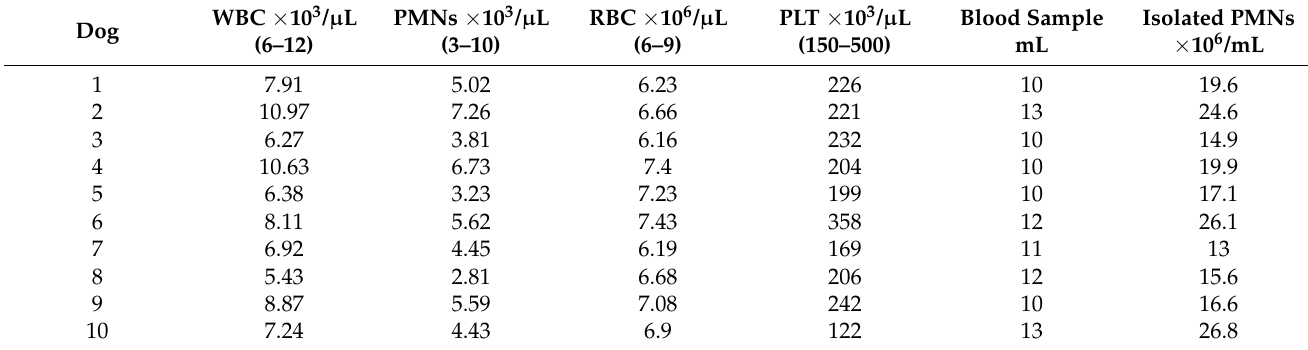
Table A1. Blood cell count of the included